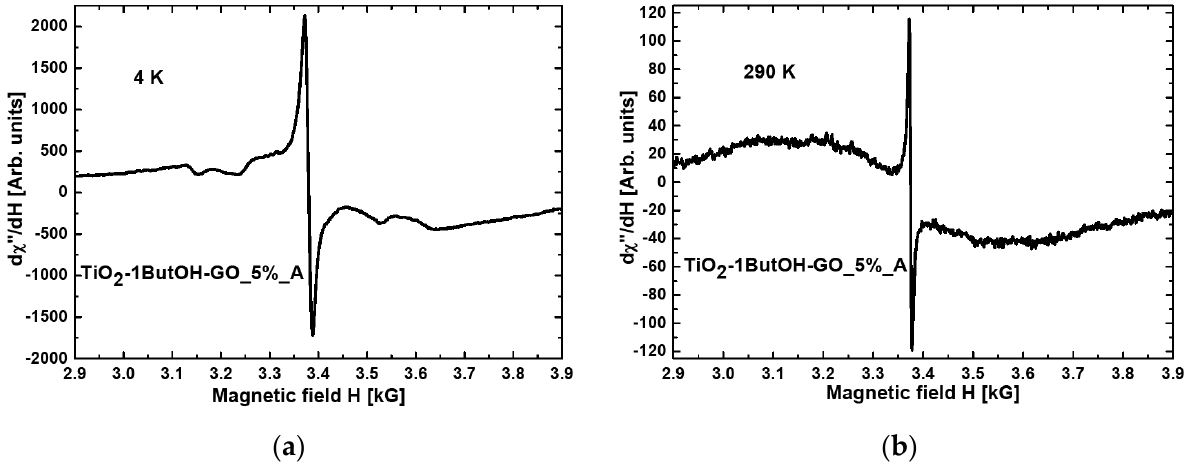
Figure 2. Magnetic resonance spectra measured at ( a ) 4 K and ( b ) RT for nanocomposite TiO 2 ‐ 1ButOH ‐ GO_5%_A.